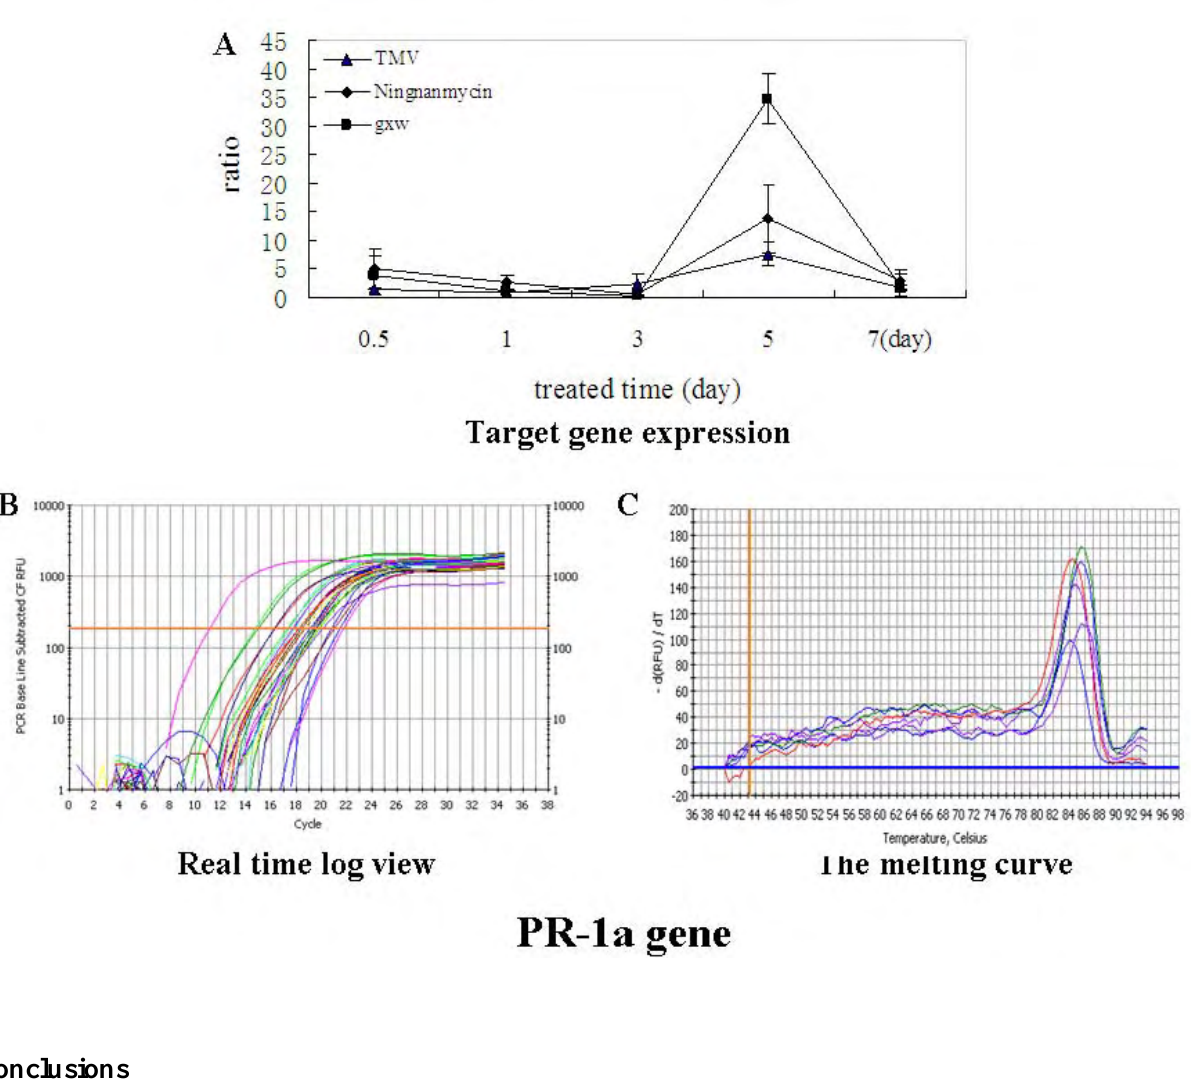
Figure 4. The real time PCR effects of PR-1a